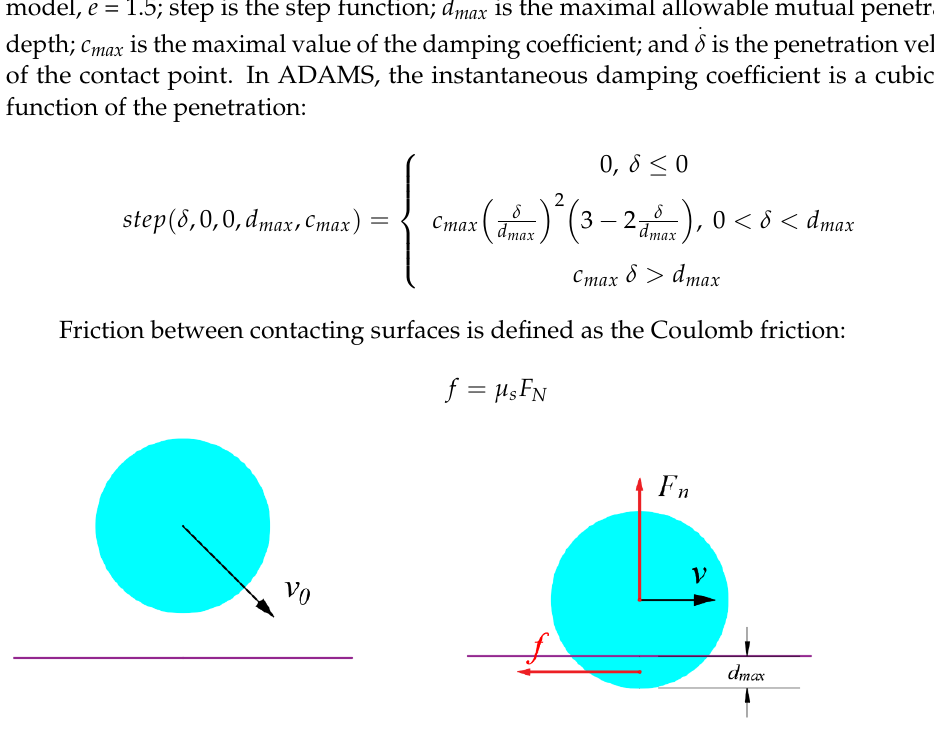
Figure 4. Example of contact mechanics model based on impact function.